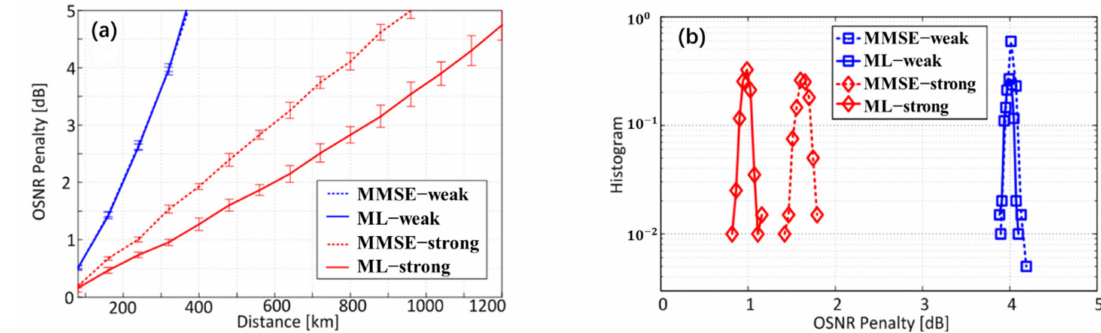
Figure 8. ( a ) OSNR penalty vs. distance and ( b ) normalized histogram of the OSNR penalty (320 km) for weakly and strongly coupled modes, MMSE equalizer and ML detection, 200 channel realizations.